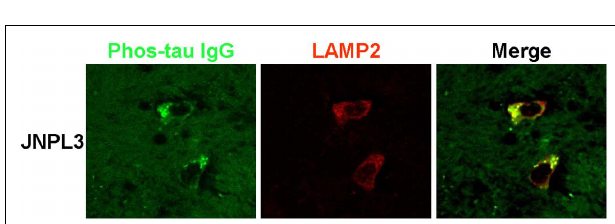
FIGURE 2 | Neuronal co-localization of FITC–IgG and LAMP2. High magnification confocal microscope images of brain slice sections from a JNPL3 transgenic mouse. Brain slices were incubated with FITC–IgG from a high titerTau 379–408[pSer 396,404 ] immunized mouse (green) and after sectioning co-stained with an antibody to LAMP2 (red), which is a marker of late endosomes and lysosomes.The merged image indicates areas of co-localization (green/yellow) between FITC–IgG and late endosomes/lysosomes, mainly in perinuclear areas.The neuronal morphology is clearly delineated by the regions of staining.